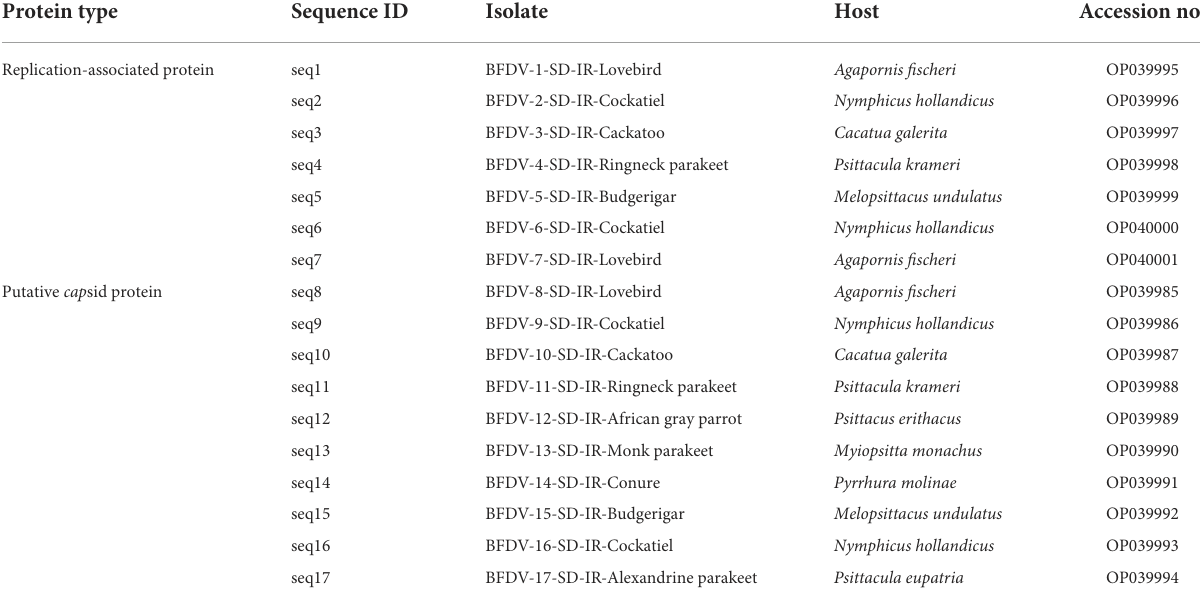
TABLE 1 Detailed information of the 17 beak and feather disease virus (BFDV) field isolates characterized in this study. Protein